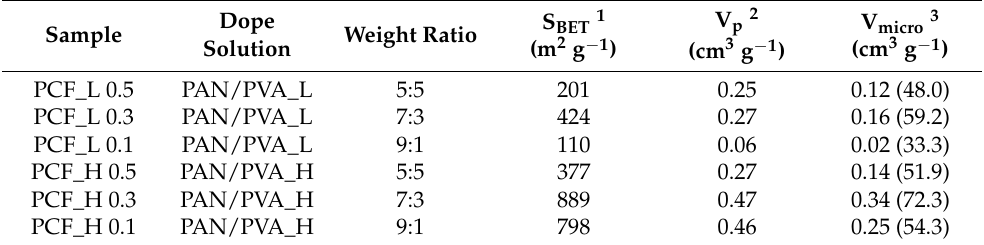
Figure 2. Cross-sectional SEM images of ( a , b ) PPFs (PVA-removed PAN/PVA bi-component fibers) and ( c , d ) porous carbon fibers (PCFs; carbonized PPFs), in which ( a , c ) low molecular weight PVA and ( b , d ) high molecular weight PVA were used when preparing the bi-component fibers. The bi-component fibers were prepared with PAN/PVA weight ratio of 5:5, 7:3, and 9:1 from left to right. The insets in ( c , d ) show side-view SEM images of each PCF. Table 1. Surface area and microporosity of porous carbon fibers (PCF) prepared from dope solutions with different weight ratios of PAN and PVA.